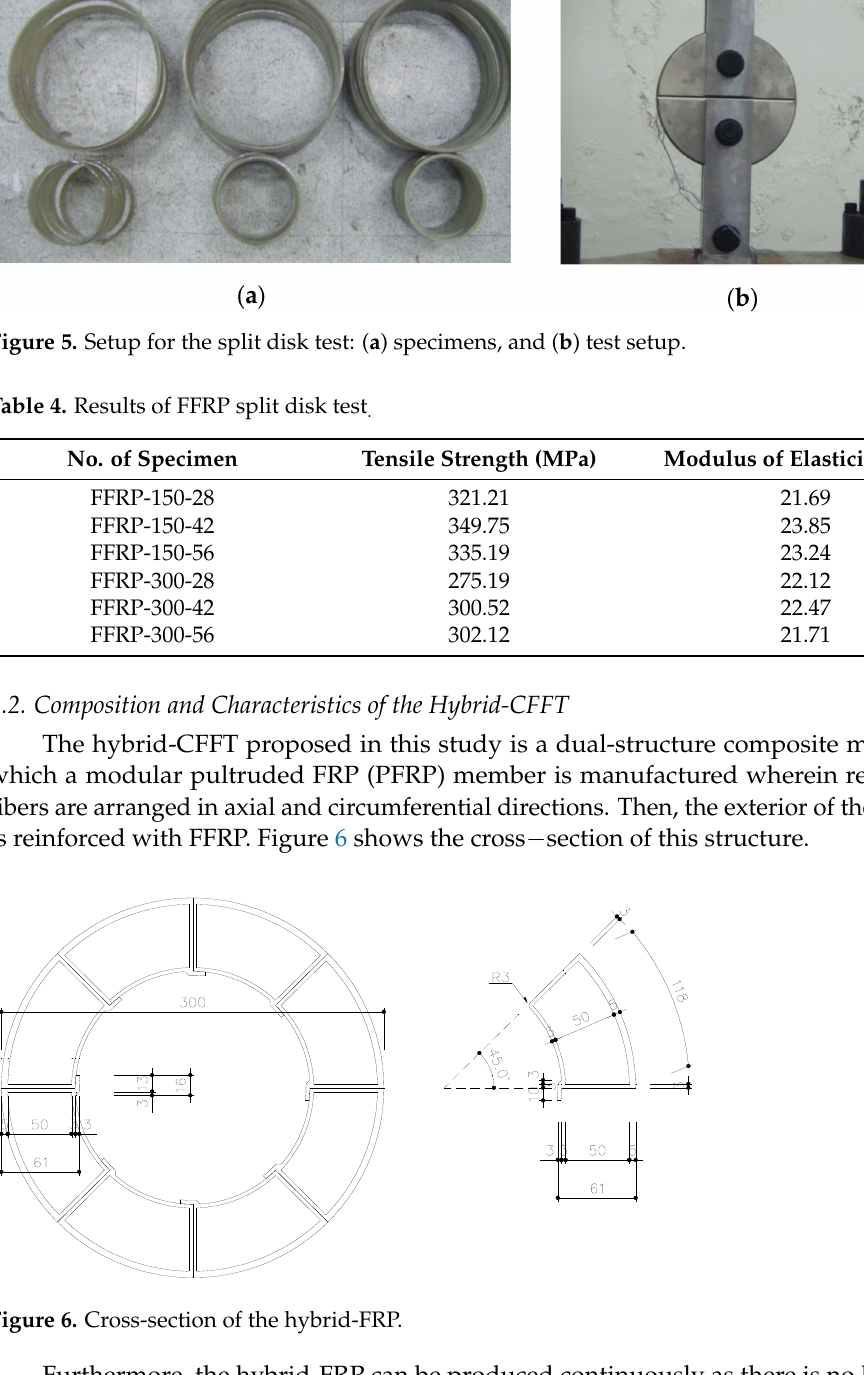
( b ) Figure 7. Manufacturing process of the hybrid − FRP member: ( a ) pultrusion process; ( b ) filament winding process. 3.3. Compressive Strength Testing of PFRP-FFRP To examine the compressive strength of PFRP-FFRP, which affects the compressive strength of the hybrid − CFFT in addition to concrete, the experimental variables of PFRP − FFRP in terms of thickness of FFRP are shown in Table 5. A testing machine that evaluates fatigue durability and can be loaded up to 30,000 kN vertically and 5000 kN horizontally was used. A vertical load of 30,000 kN was applied for the compressive test. A strain gauge was attached to each specimen center in the longitudinal and orthogonal directions, and a displacement gauge with a capacity of 100 mm was installed to measure the compressive displacement in the longitudinal direction. A compression tester with a capacity of 30,000 kN was used to apply the load. The compressive strength test, as shown in Figure 8, was performed according to KS F 2405 [24]. The load was applied at 150 kN/min using a load-controlled method.